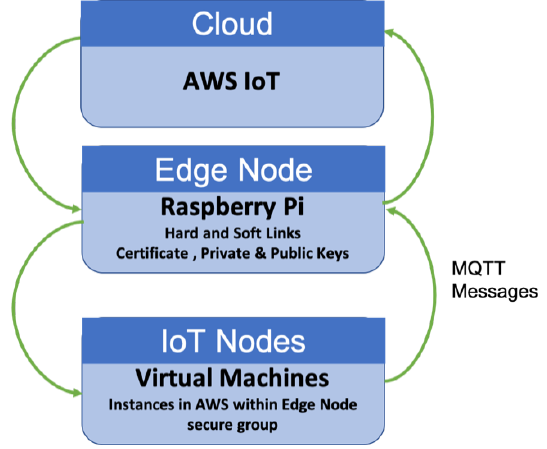
Figure 3. The proposed system model.